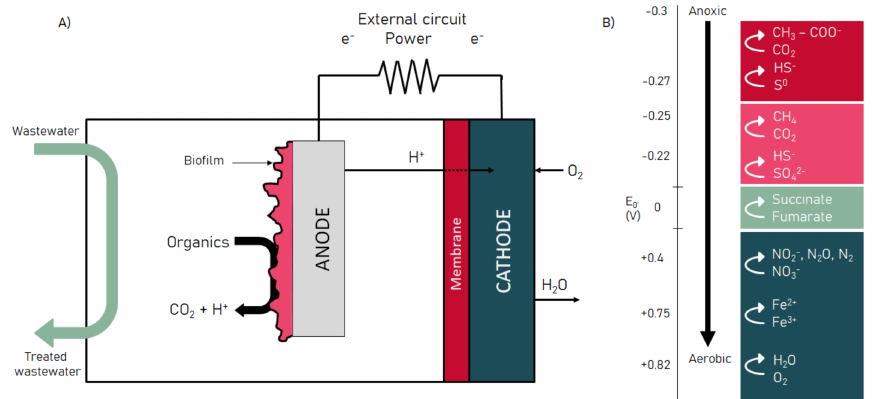
Figure 3. Diagram of an MFC reactor ( A ) and chemical changes in an MFCs depending on the oxygen conditions ( B